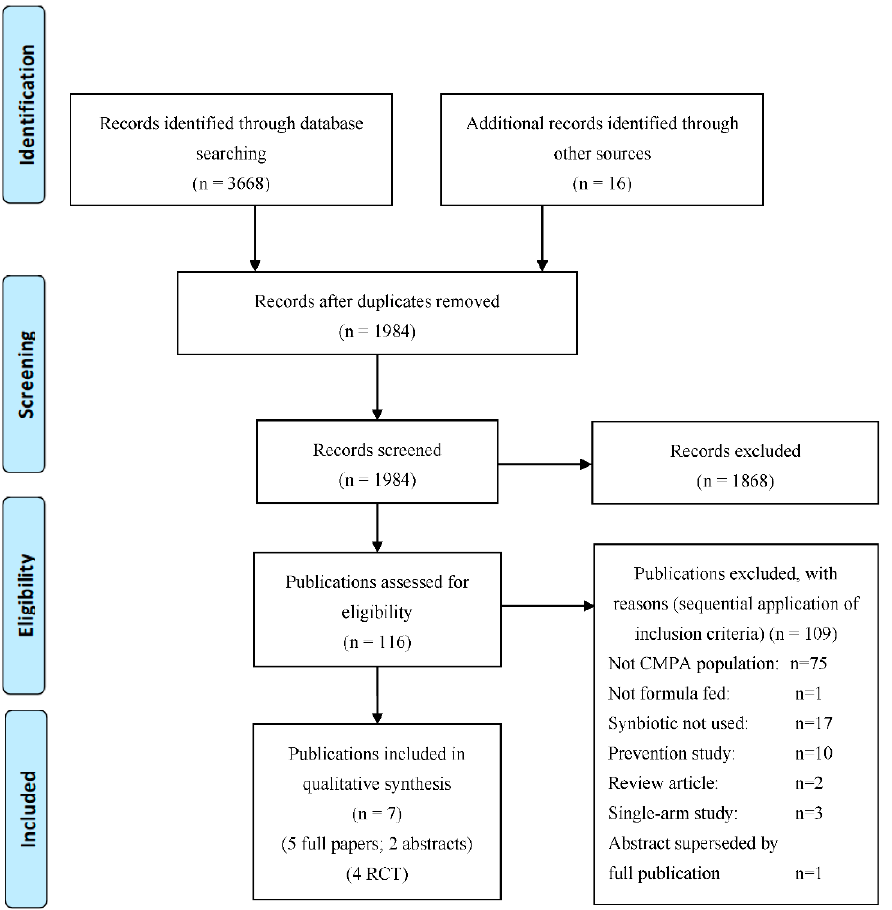
Figure 1. PRISMA flow